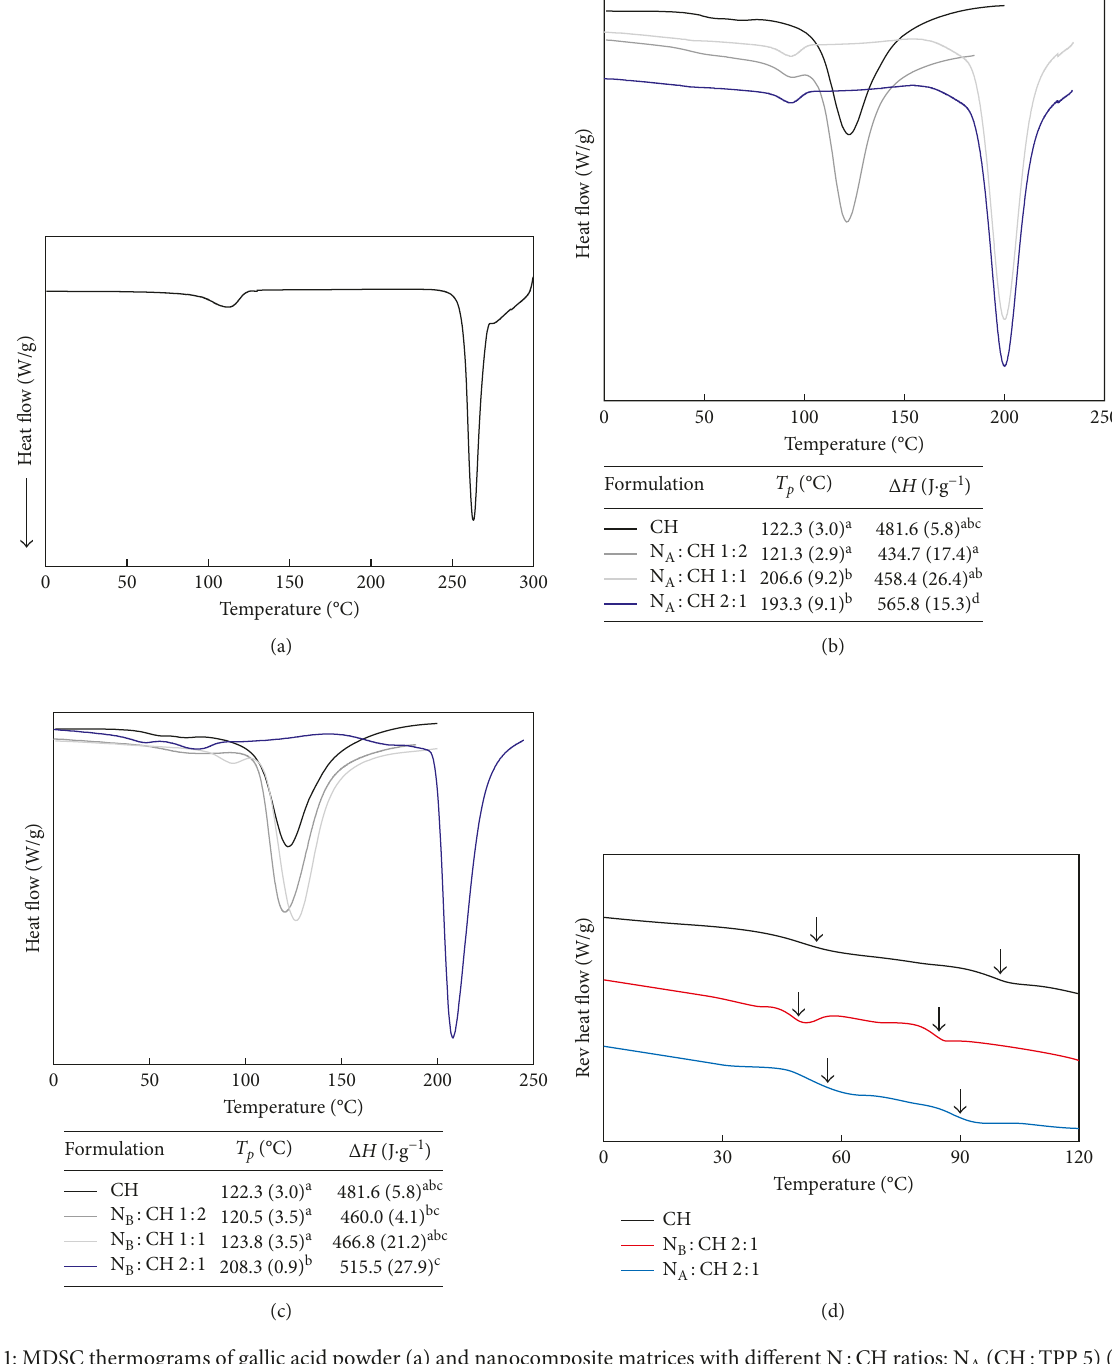
A (CH :TPP 5) (b), and